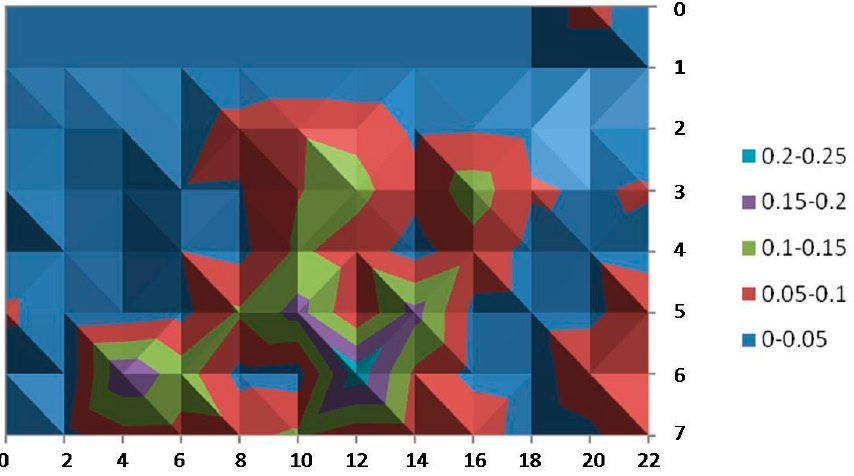
Figure 10. Standard deviation of the samples taken for the y-coordinate.